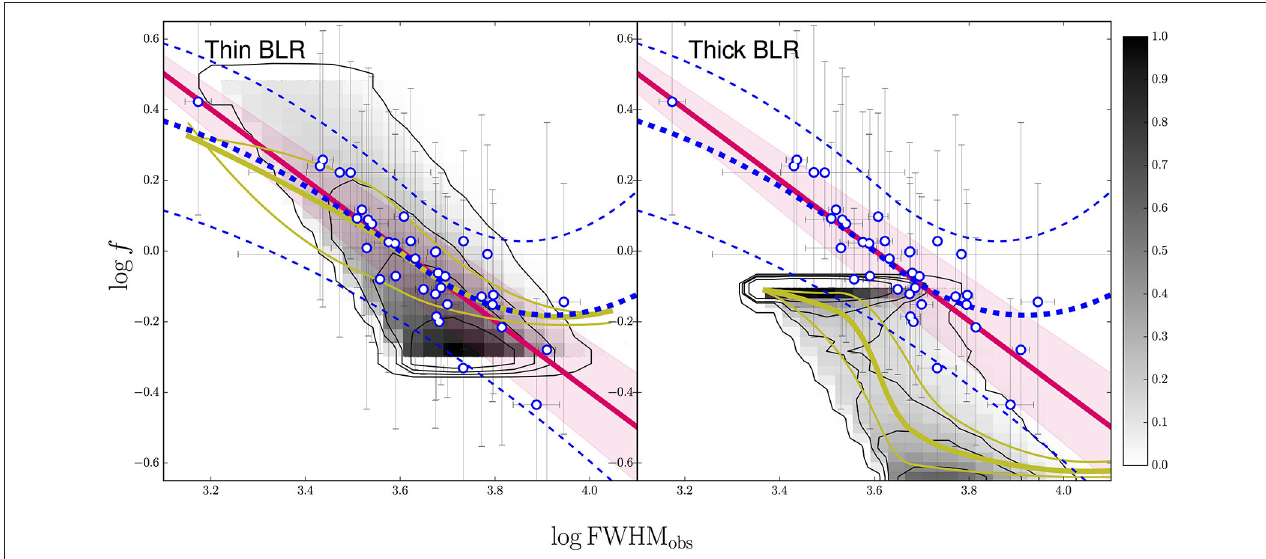
FIGURE 2 | Virial factor–FWHM obs bi–dimensional distributions for a thin and thick BLR. Predicted bi-dimensional probability distribution functions of the virial factor and FWHM obs for a thin BLR (left) and a thick BLR (right) , as predicted by the best-fit models, are shown in gray. The darkest regions represent the most probable combinations of these quantities as quantified in the color-bar. The thin black lines are the 25, 50, and 75% and 99% confidence limit contours centered around the maximum probability point. The thick yellow lines are the median of the f − FWHM obs distributions derived from a quantile non-parametric spline regression (COBS). The open-blue circles are data from the right panel of Figure 1 for the H α line. The magenta lines are the derived relation f = (cid:16) FWHM obs ( H α)/ 4,000 kms − 1 (cid:17) and the shadowed regions the associated uncertainties. The thin blue-dashed lines are the 25, 50, and 75% quantiles of the observational distribution after accounting for the measurement errors in f AD and FWHM obs (H α ). We see that for the thin BLR the 50%-quantile (median) of the theoretical and observational distributions are in very good agreement with each other. Additionally, the distribution of the data points shows good agreement with the predicted bi-dimensional distribution confidence limits. Explicitly, we find that 21% of the points fall inside the central 25% confidence level region, 51% fall inside the 50% confidence level region, 78% fall inside the 75% confidence level region, and 87% fall inside the 99% confidence region level. On the other hand, the thick BLR model cannot reproduce the bi-dimensional f − FWHM obs